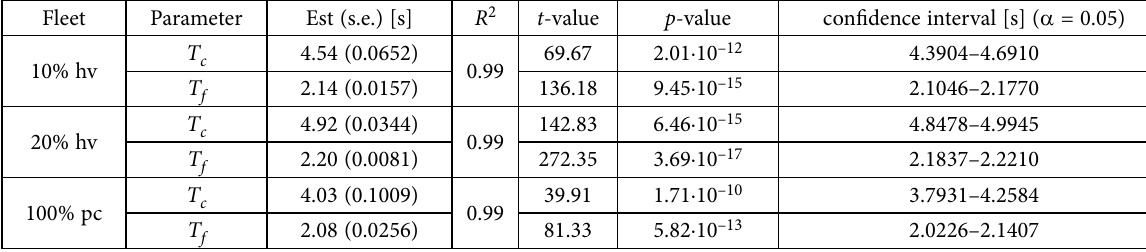
Table 3. Results of regressions for the right-lane on minor entries